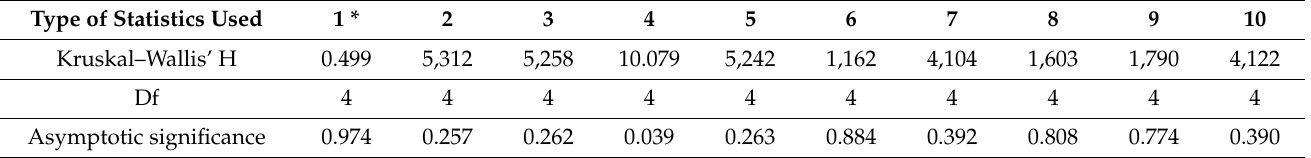
Table 5. Preference for a particular type of onboarding and the respondents’ age (tested value a,